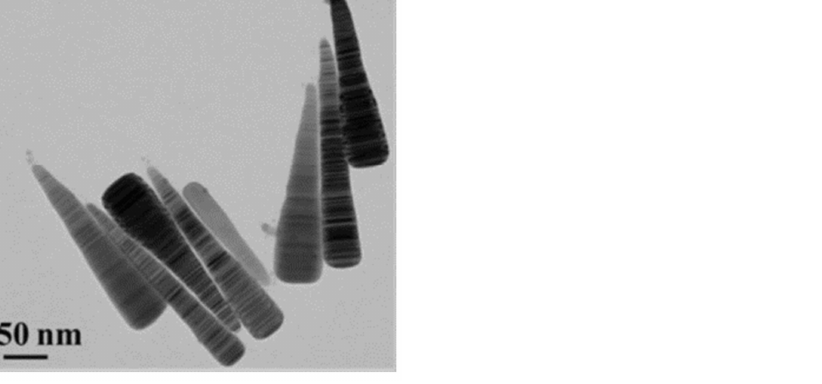
Figure 10. TEM image of silver nanocarrots. Adapted with permission from